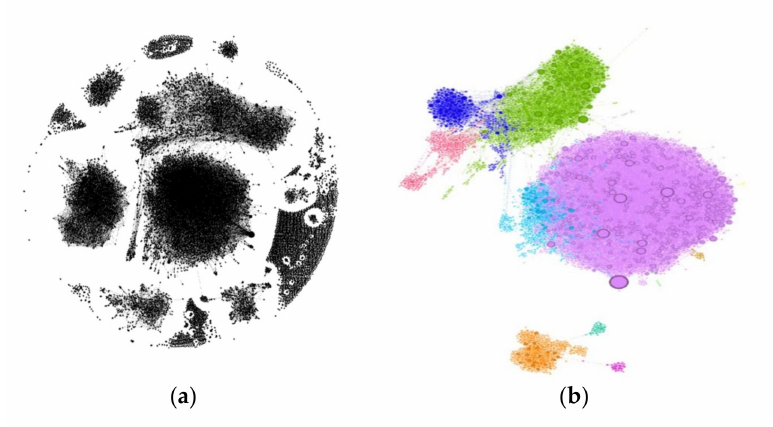
Figure 1. Representation of the communities investigating extremely low frequency (ELF). ( a ) Representation of the total untreated communities. ( b ) Representation of communities after